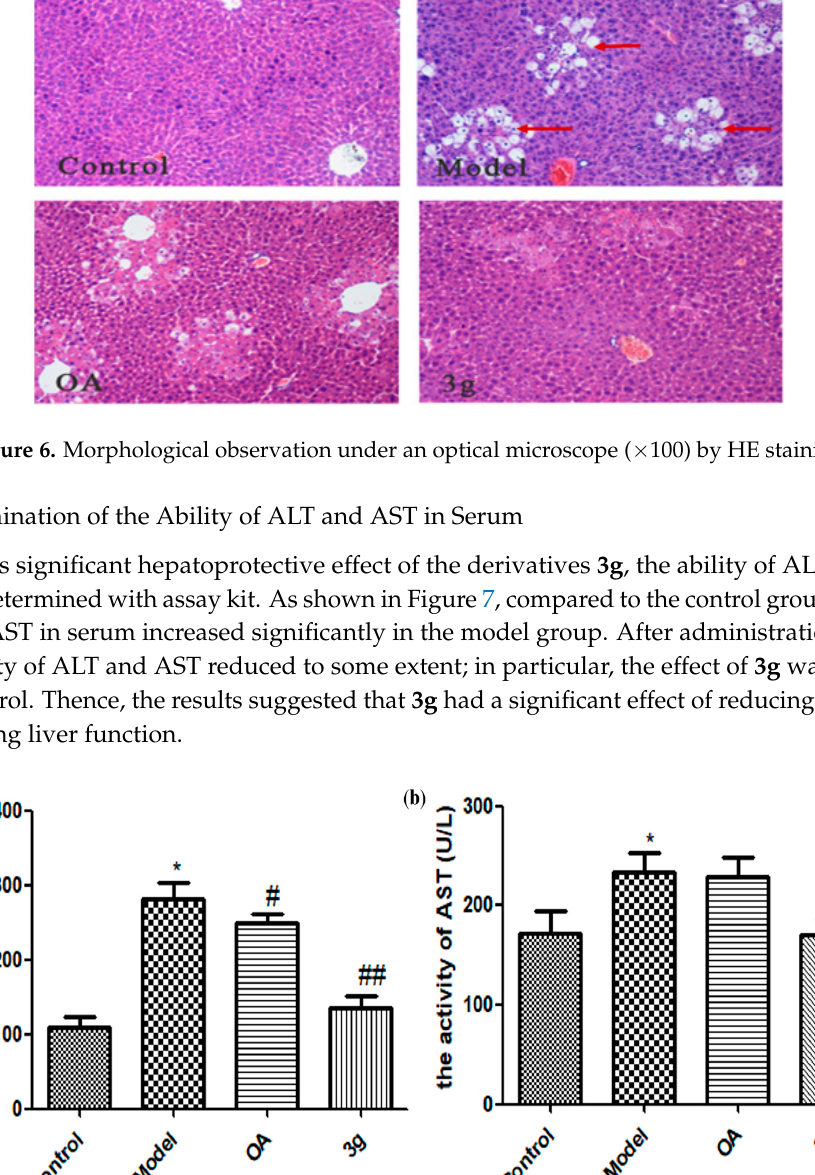
Figure 7. The activity of ALT ( a ) and AST ( b ) on CCl 4 acute liver injury mice model after administration of OA and 3g . Values are expressed as the mean ± SD in each group ( n = 12). * p < 0.01 vs. Control, # p < 0.01, ## p < 0.001 vs. model.